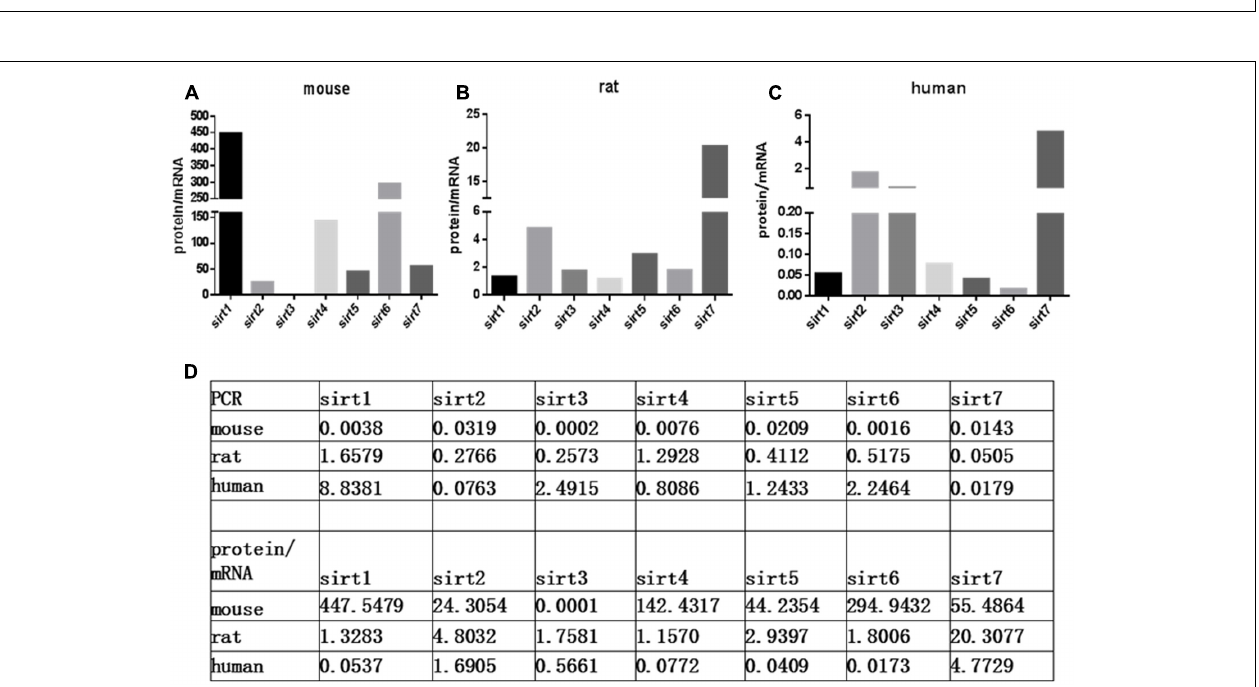
FIGURE 2 | Sirtuin (SIRT1-7) protein levels in mouse, rat, and human retinal neurons. Representative western blots showing the protein levels for SIRT1 (A) , SIRT2 (B) , SIRT3 (C) , SIRT4 (D) , SIRT5 (E) , SIRT6 (F) , and SIRT7 (G) in the retinas of each species. The histograms in each panel show the densitometric mean and SEM normalized to the corresponding level of the loading control protein β -Tubulin ( n = 4 independent subjects). Statistical comparisons between the expression levels of the different Sirtuin proteins in the retinas of adult mouse, rat, and human are presented as a table (H) .